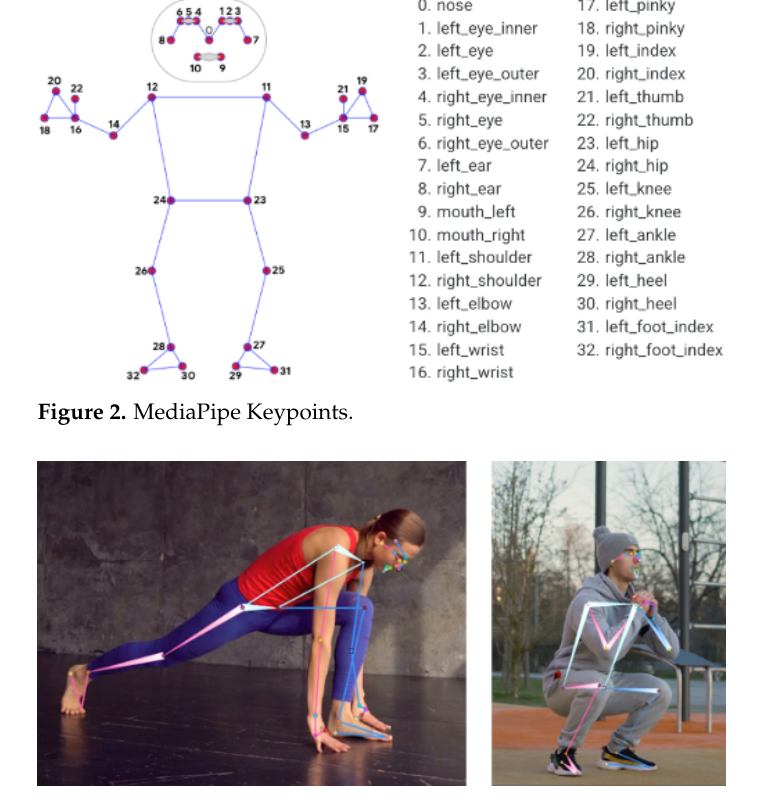
Figure 3. MediaPipe Keypoints on Actual